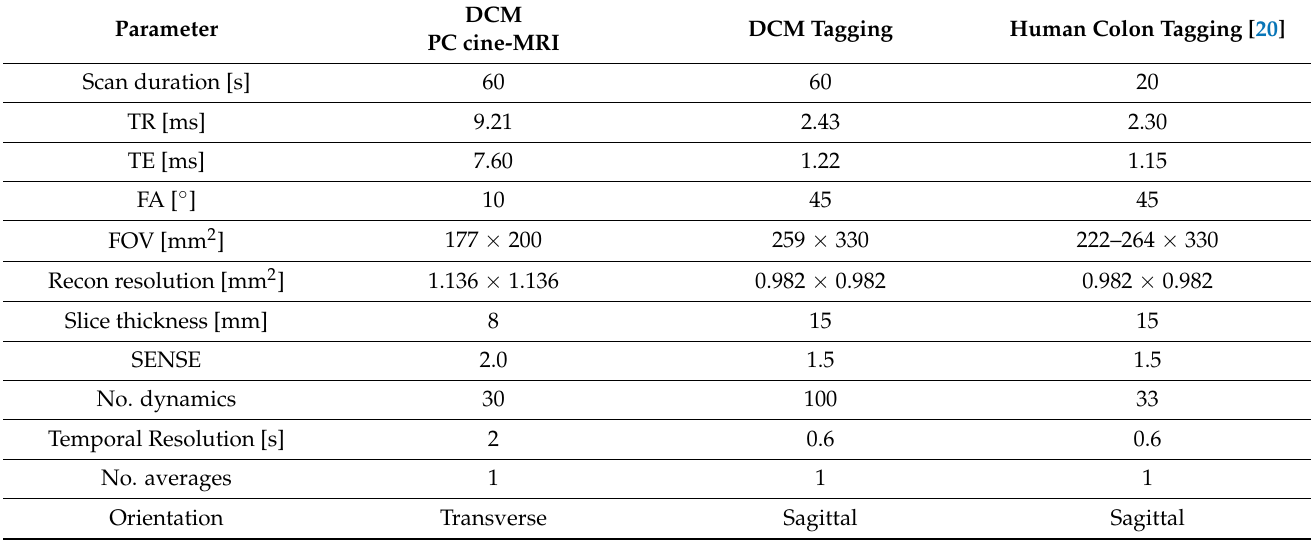
Table 1. Imaging